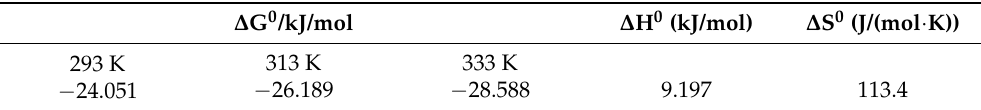
Table 3. Thermodynamic parameters of Fe(III) on HAP.